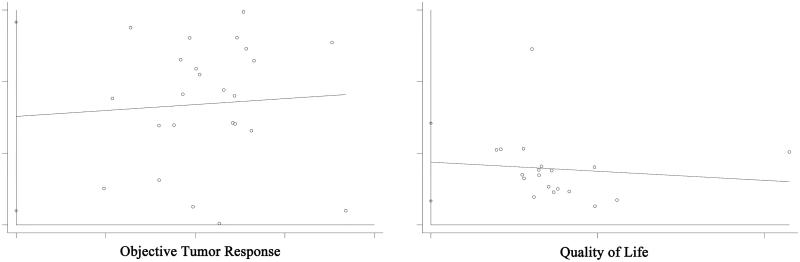
Publication bias of objective tumor response rate and performance status.